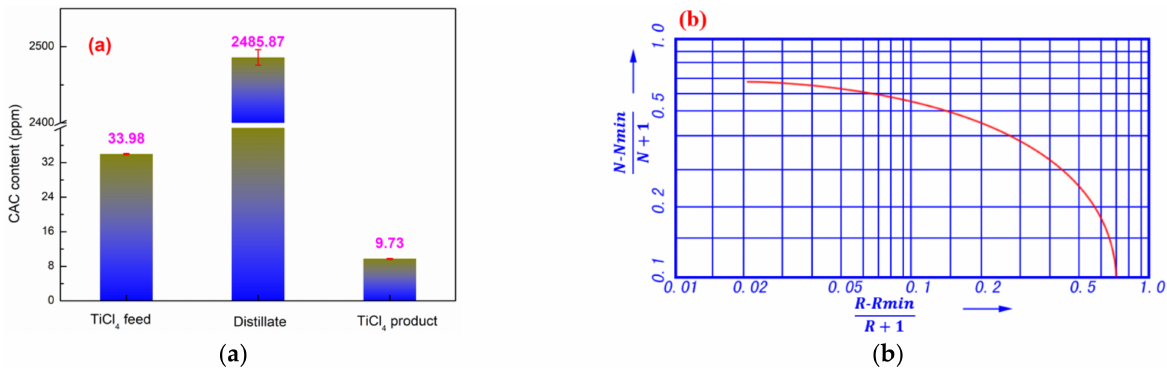
Figure 3. ( a ) The CAC content in different parts of the rectifying column and ( b ) the Gillian correlation